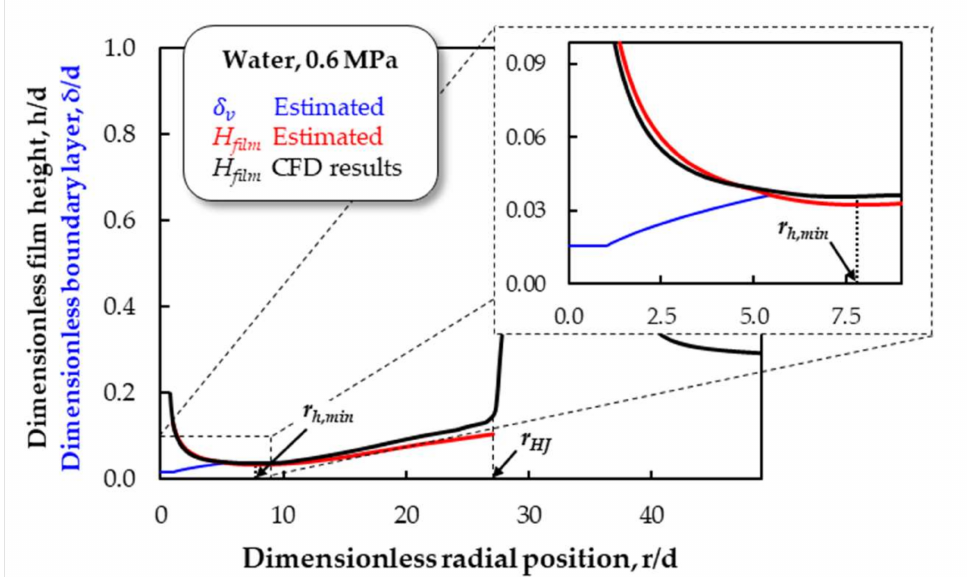
Figure 10. Comparison between numerical and empirical formulation results to estimate the viscous boundary layer thickness (blue line), fluid film height (black line from CFD results; red line from empirical equations), and dimensionless positions of the minimum height of the fluid film, r h , min , and hydraulic jump, r HJ .